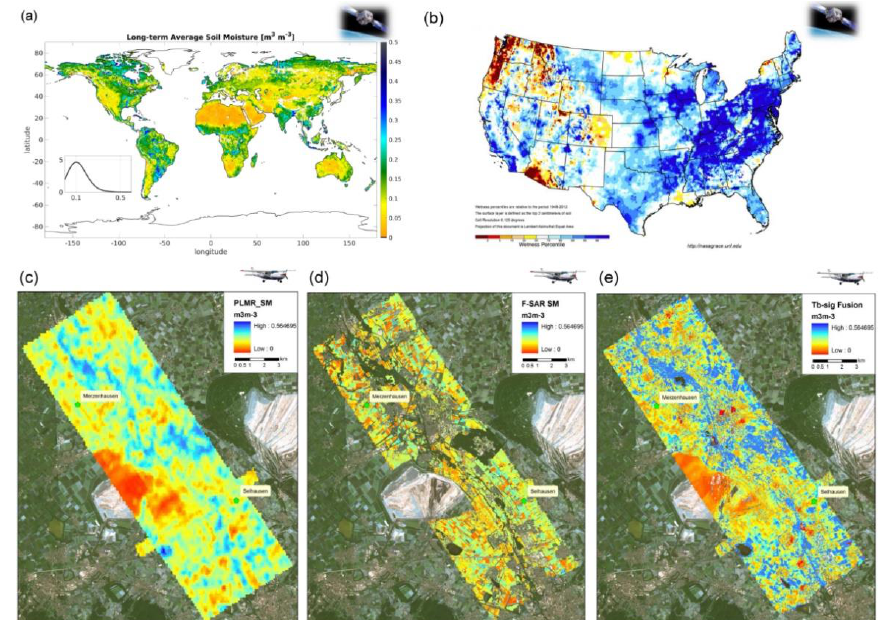
Figure 7. Soil moisture patterns and indicators derived from ( a ) soil moisture and ocean salinity mission (SMOS;from Piles et al. [314]), ( b ) NASA’s gravity recovery and climate experiment (GRACE) satellites (https://nasagrace.unl.edu/data/20190506/GRACE_SFSM_20190506.png, ( c ) low-resolution passive microwave, ( d ) high-resolution active microwave, and ( e ) medium-resolution (combined) active-passive microwave (brightness temperature disaggregation) observations of the multi-sensor platform (PLMR and F-SAR) for the agricultural and mining region around Jülich, Germany (modified after Montzka et al. [301]).